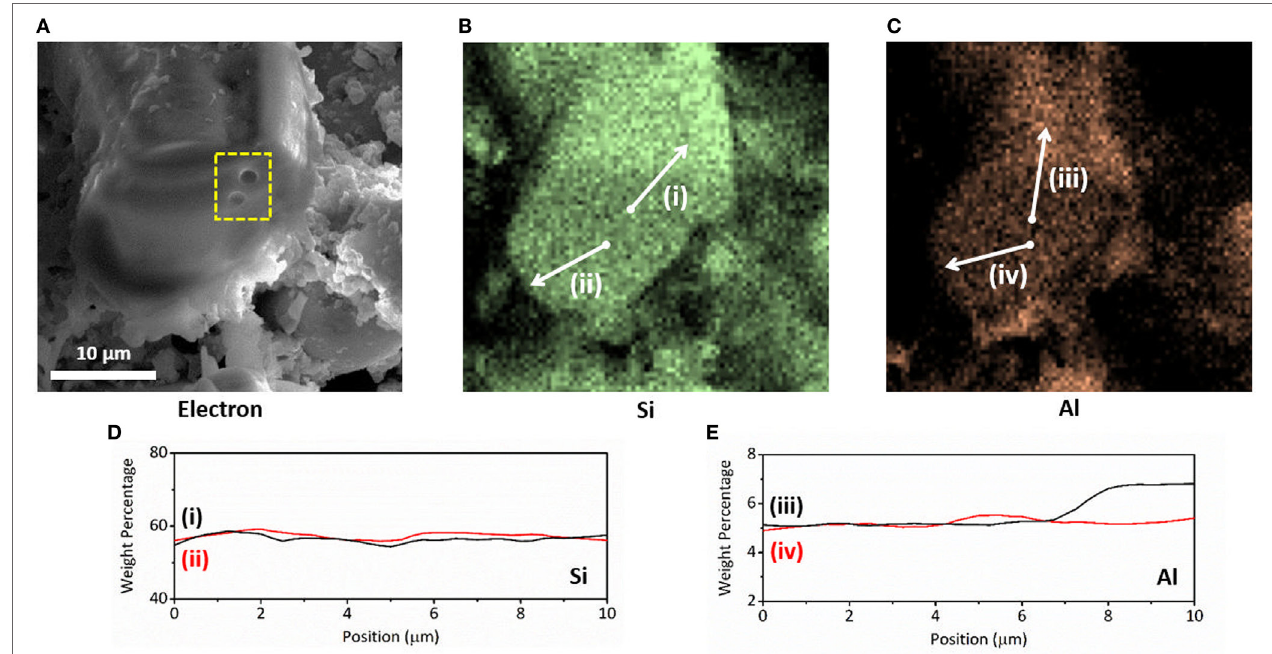
FigUre 4 | Internal compositional analysis of a surface fiber: (a) scanning electron microscope image through a sectioned fiber, the highly amorphous/structure- less internal form of the material is apparent alongside two small voids (highlighted); (B) energy dispersive spectroscopy (EDS) elemental map of Si distribution; (c) EDS elemental map of Al distribution; (D) Si compositional line-scans (i) and (ii) as shown in (B) ; (e) Al compositional line-scans (iii) and (iv) as shown in (c)